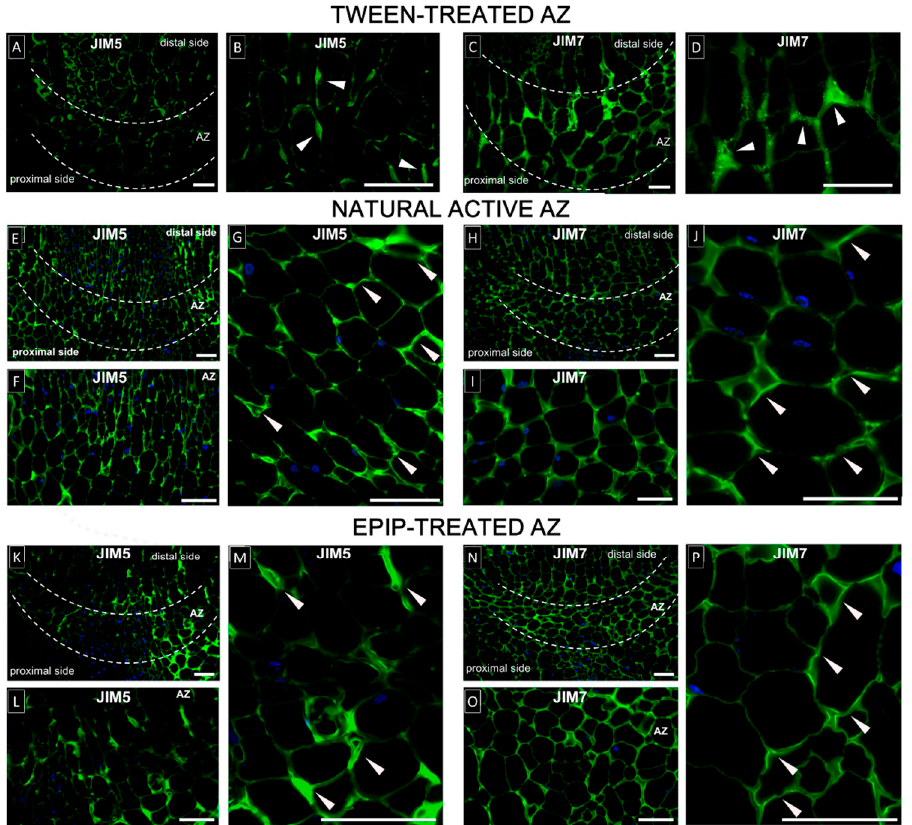
Figure 7. EPIP affects pectin cell wall composition in the floral AZ. Immunofluorescence localization of methylesterified pectin was performed in the yellow lupine flower abscission zone (AZ). Green fluorescence indicates low methylated and unmethylated HGs (JIM5 labeling A , B , E – G , K – M ) and high methylated HGs (JIM7 labeling, C , D , H – J , N , O , P ). Immunoflu- orescence reactions were performed for the Tween-treated AZ ( A – D ), naturally active AZ ( E – J ), and EPIP-treated AZ ( K – P ). The 0.05% Tween 20 or EPIP peptide solution (100 µ M in 0.05% Tween 20) were applied directly to inactive AZ. The plant material was collected 6 h after each treatment ( A – D , K – P ). Naturally active AZ was excised from abscised flowers ( E – J ). Fluorescence signal corresponding to pectin presence is indicated by arrows. Nuclei were stained with DAPI (blue fluorescence). AZ regions are marked by white, dotted lines. Bar—50 µ